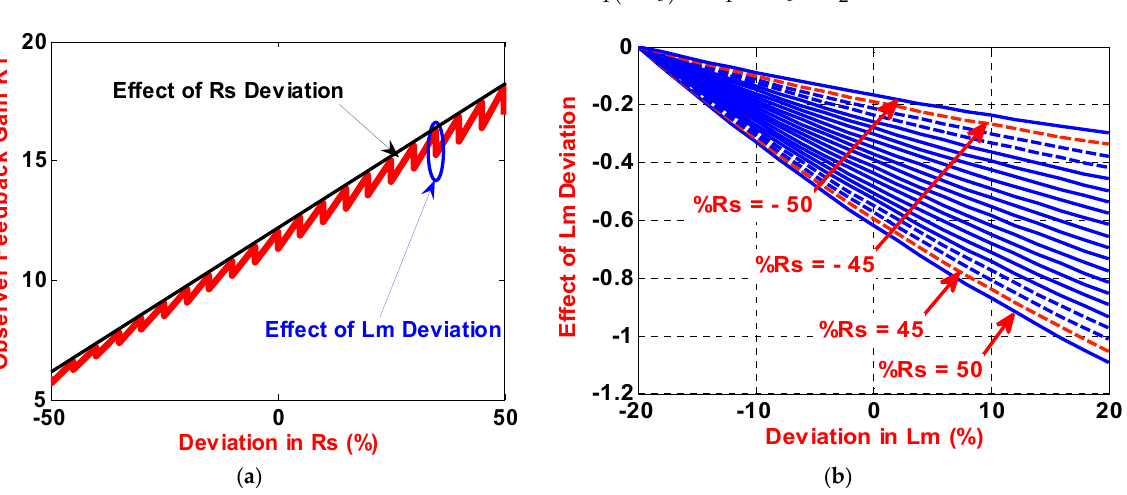
Figure 7. Effect of deviation in Rs and superimposed effect of deviation in L m on the observer feedback gain K 1 using PSO. ( a ) Under stator resistance deviation; ( b ) under magnetizing inductance deviation.